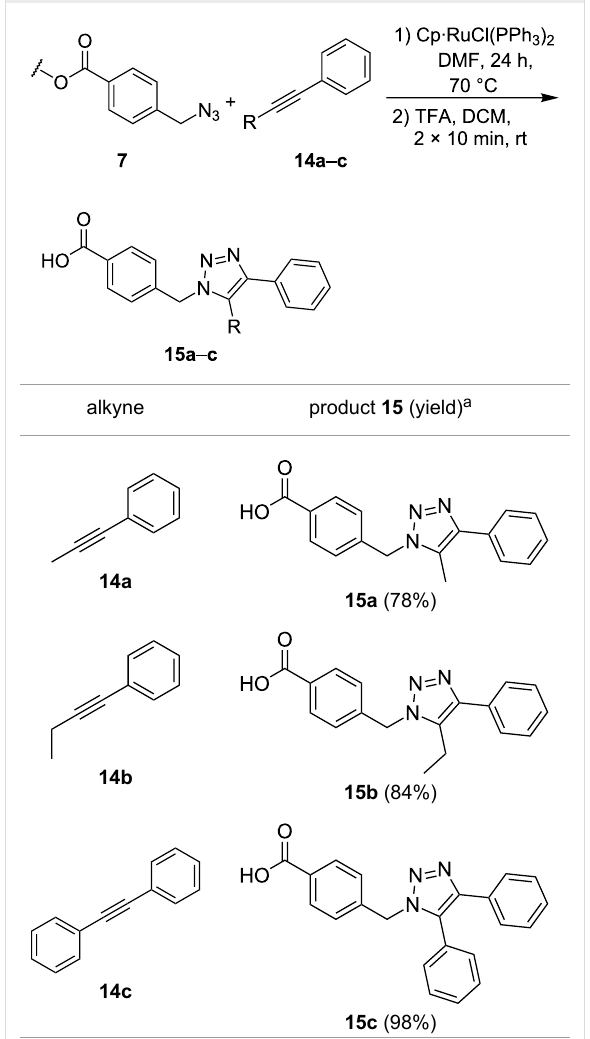
Table 3: Ruthenium-catalyzed [2 + 3] cycloadditions of resin-bound azide 7 with three disubstituted